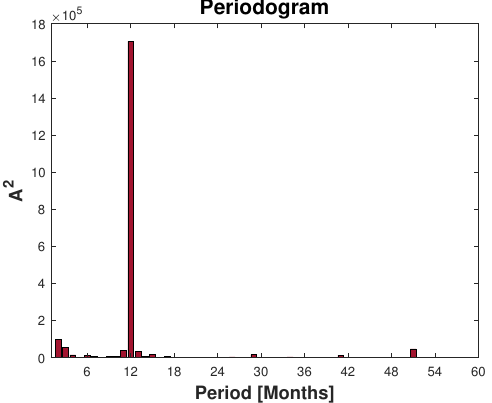
Figure 6. Periodogram of the MEL time series for